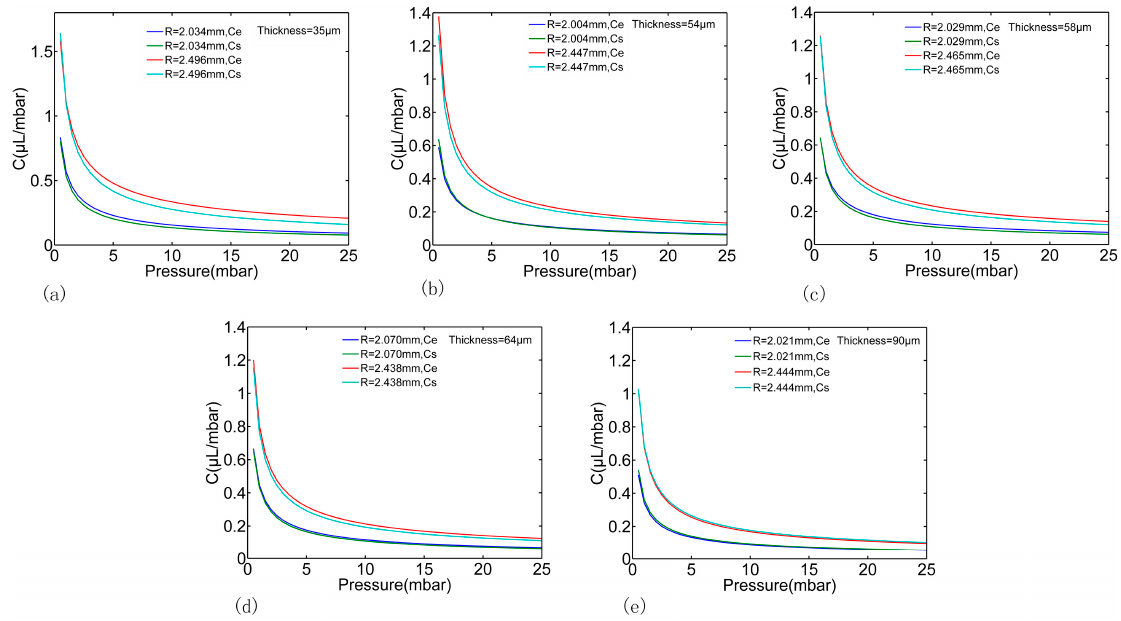
Figure 11. The experimental pressure-capacitance relationship of the PDMS membrane. “Ce” and “Cs” are the hydraulic capacitances obtained by experiments and theoretical estimation respectively. Subplot ( a – e ) represent the thickness of the PDMS membrane from 35 to 90 μ m.